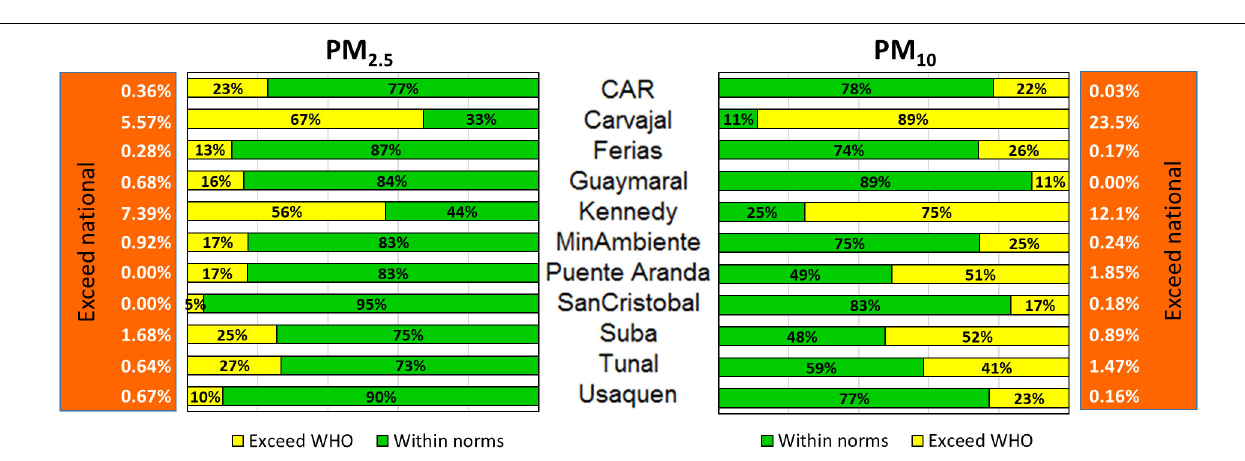
Frontiers in Environmental Science |